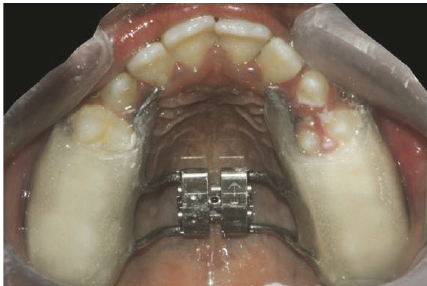
Figure 2: RME with Hyrax Expansion.